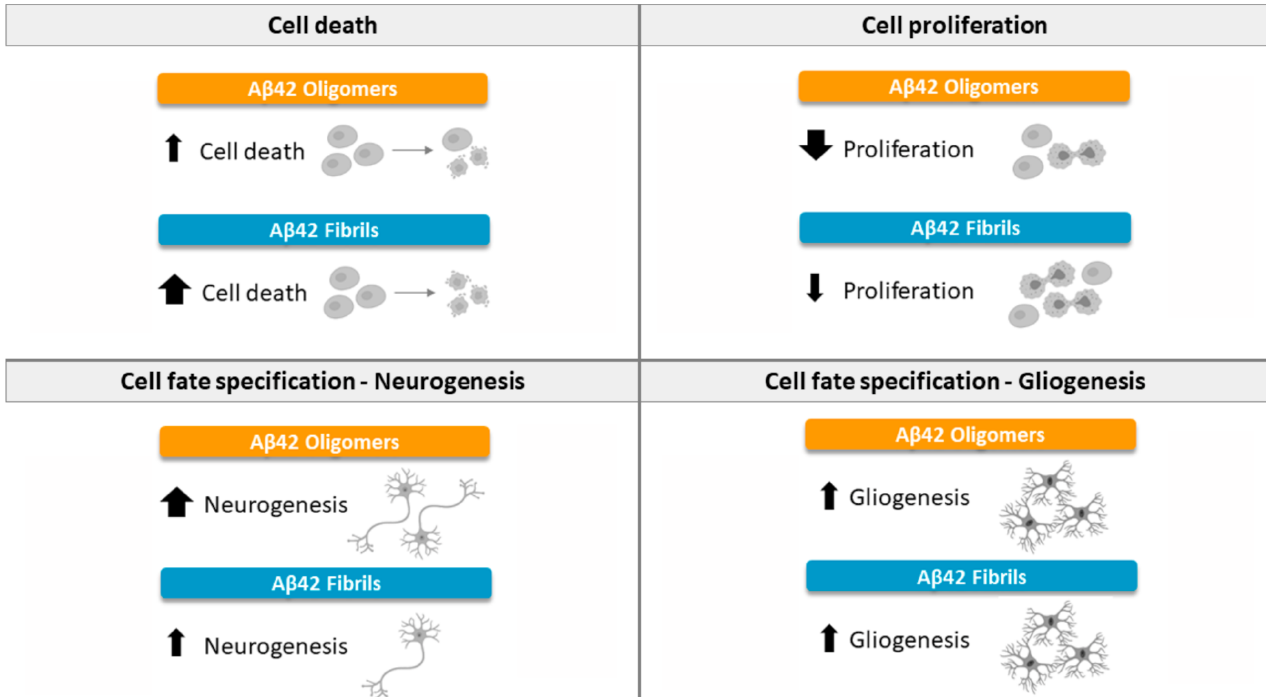
Figure 6. Summary of the effects of A β 42 peptide (oligomeric and fibrillary) on cell death, proliferation, and differentiation of NSCs. Positive effects are indicated by upward arrows. Negative effects are indicated by downward